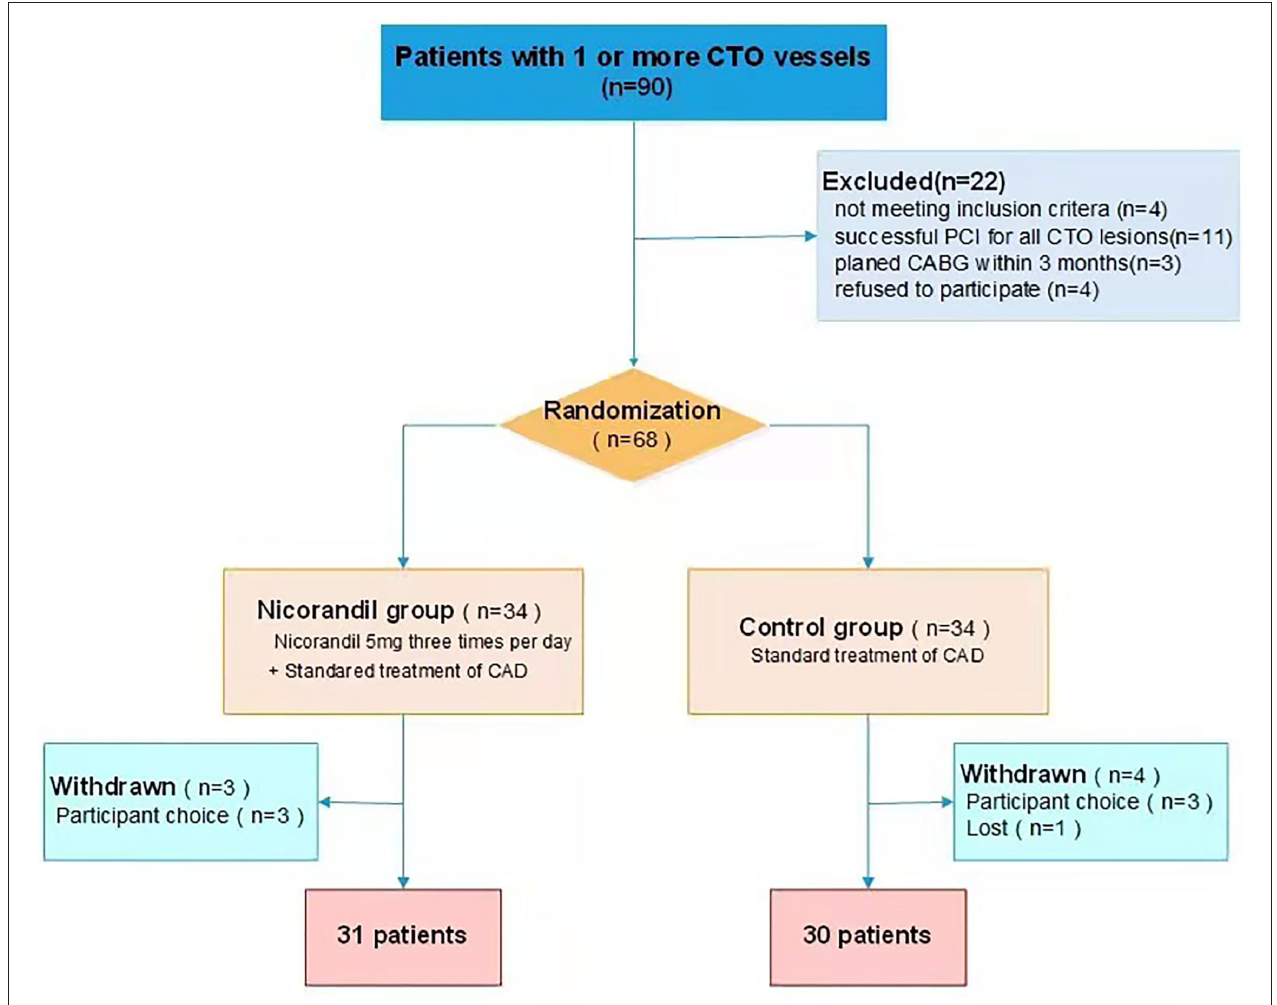
FIGURE 1 | Patient flow chart. CABG, coronary artery bypass grafting; CTO, chronic total occlusion; PCI, percutaneous coronary